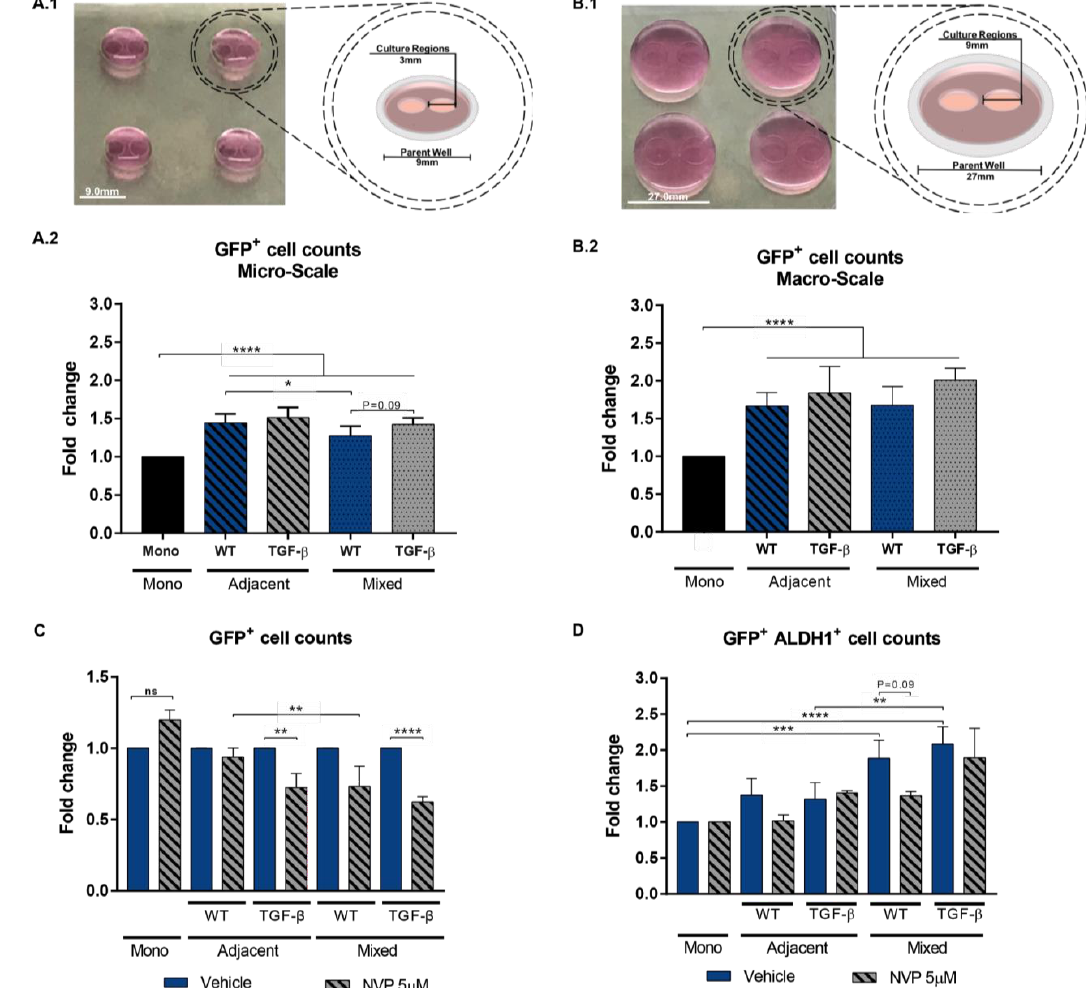
Figure 4. Impact of fibroblast subtypes and proximity among co-cultures. ( A.1 , B.1 ) Image and schematic of microscale and macroscale microwell culture platforms used for co-culture studies. ( A.2 , B.2 ) MDA-MB-231 Green fluorescent protein (GFP) + were cultured alone or in mixed or adjacent